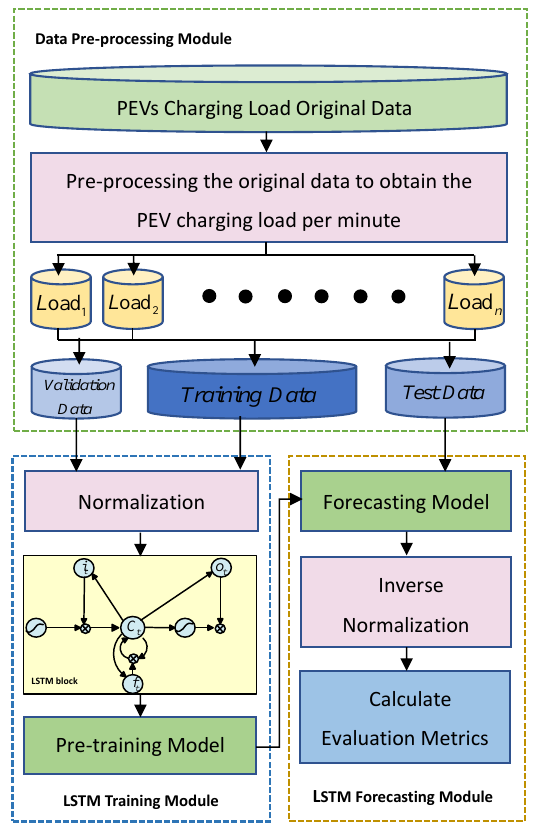
Figure 3. The LSTM based forecasting